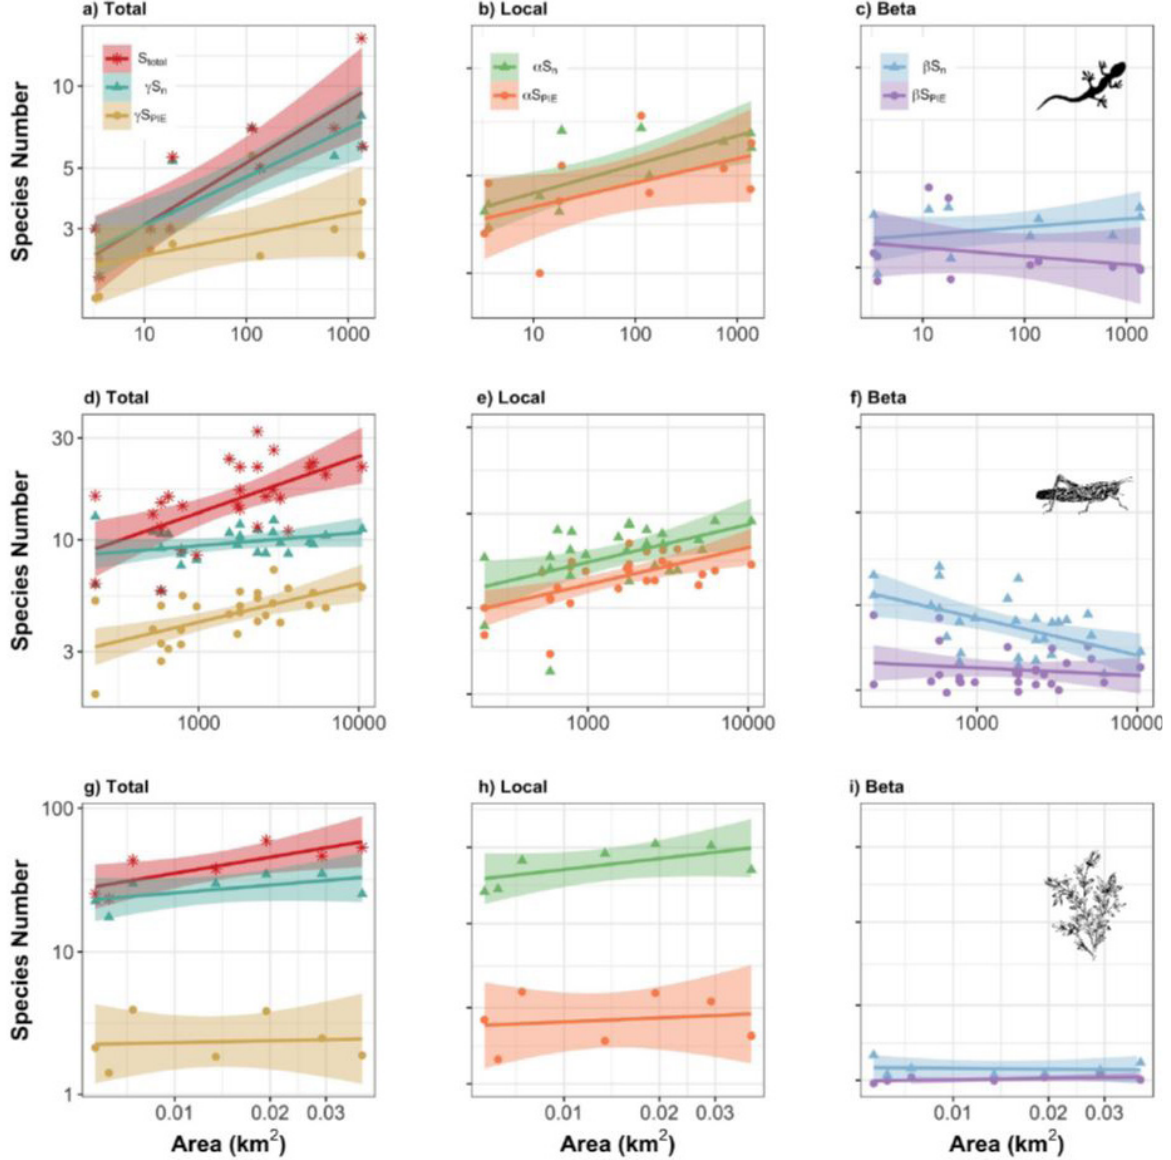
Figure 4. Log-log plots from the three case studies. Each row represents results from a different case study; top row is for the lizards on the Andaman Islands; middle row is for the grasshoppers in Ozark glades; bottom row is for plants in Israeli fragments. Panels a), d), and g) represent parameters derived from the regional scale, including S (the number total of species estimated on the total island), γ S (the number of species expected for a minimum N measured across plots), n and γ S (the effective number of species given PIE across plots; see text for explanation). Panels b), e), and h) represent PIE parameters derived from the local scale, including α S (the number of species expected for a minimum n measured in a single n plot) and α S (the effective number of species given PIE within a plot). Panels c), f), and i) represent parameters derived PIE from comparing the local and regional scale (=β-diversity), including β (the difference which represents heterogeneity n S in rare and common species) and β (the difference which represents heterogeneity in common species). Coefficients PIE S and significance values are given in Table 1. Images are CC0 Creative Commons, with no attribution